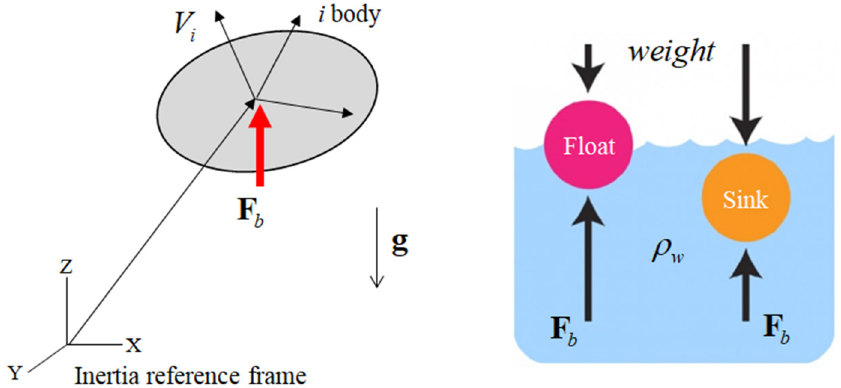
Figure 4. Buoyancy kinematic relationship between a body i and